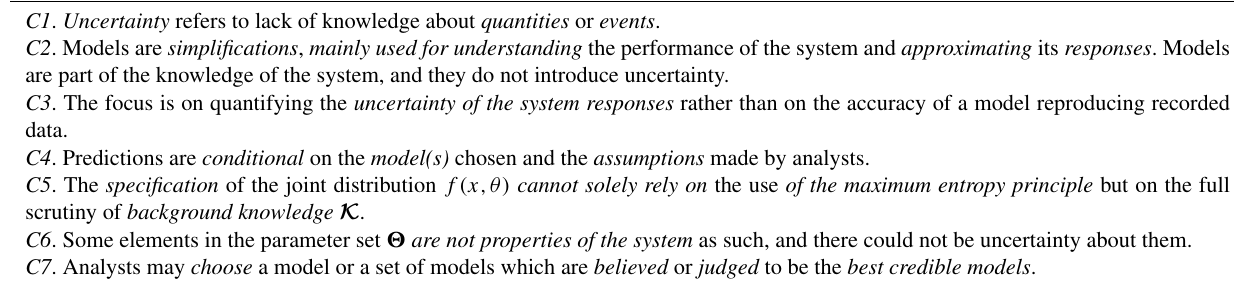
Table 3. Some clarifications and considerations to address the challenges in